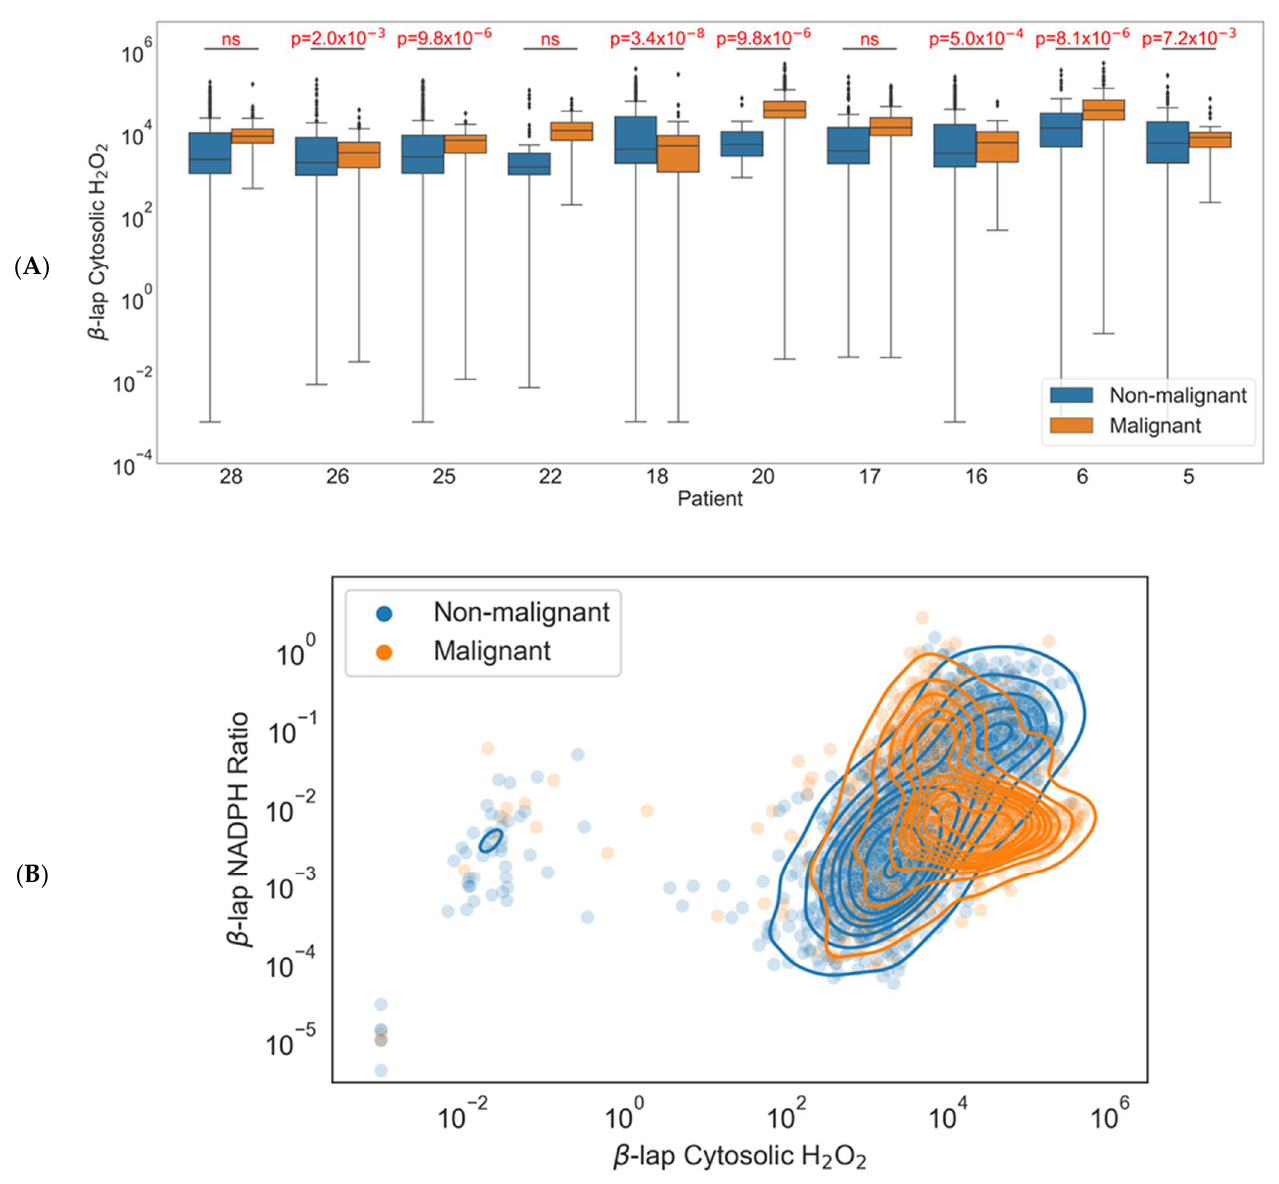
Figure 4. Model results using single-cell gene expression values. ( A ) Differences between cytosolic H 2 O 2 in healthy and malignant cells under β -lapachone by patient. Boxes are defined by the interquartile range (IQR) with the line inside representing the mean. Upper whiskers are defined by adding 1.5 times the IQR to the third quartile, and lower whiskers are defined by subtracting 1.5 times the IQR from the first quartile. Black diamonds represent outlier samples outside the whiskers. ( B ) Differences between the NADPH:NADP + ratio and cytosolic H 2 O 2 in healthy and malignant cells under β